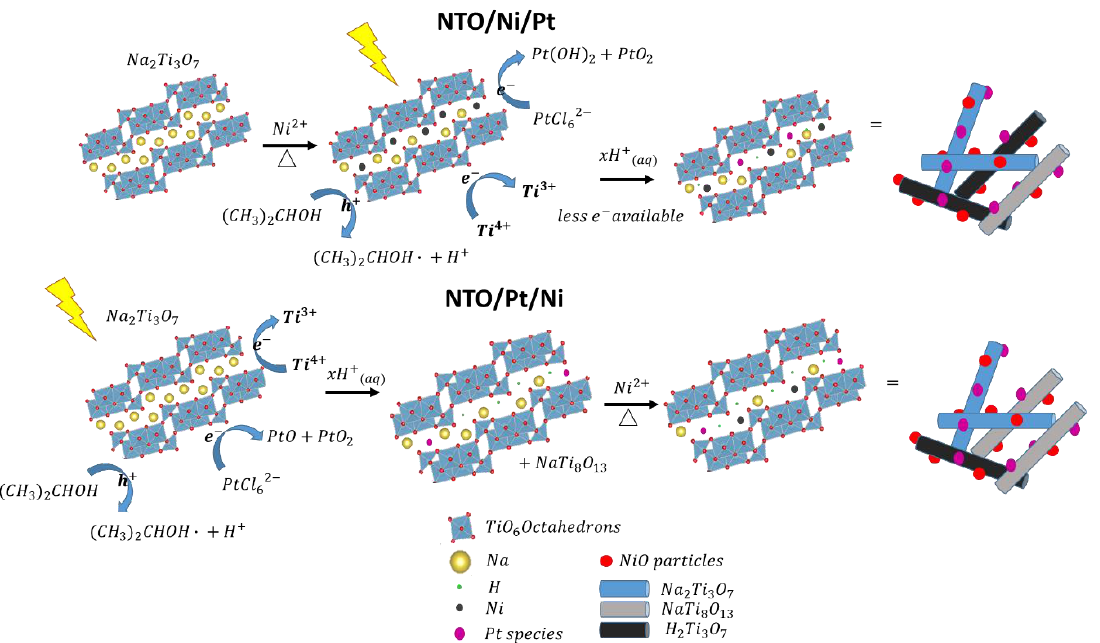
Figure 9. Proposed reaction mechanism of the phase transition during the bi-metallic Na 2 Ti 3 O 7 synthesis.